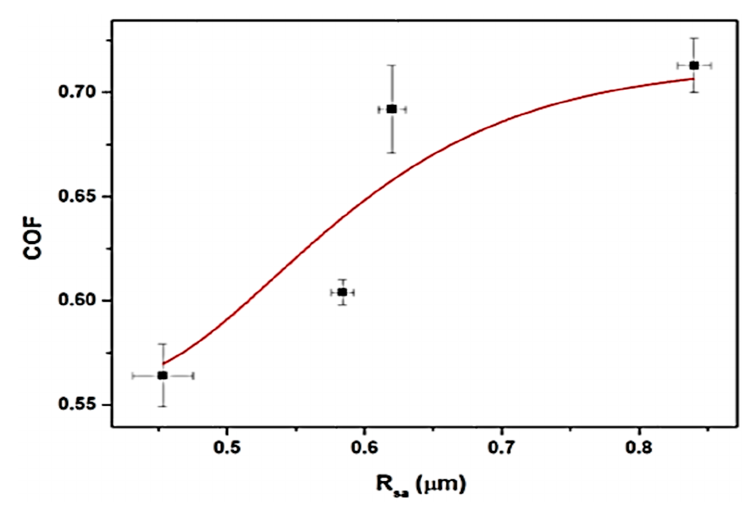
ffi cient vs. roughness surface of NiTec Figure 11. Friction coefficient vs. roughness surface of NiTec coatings. Figure 11. Friction coe